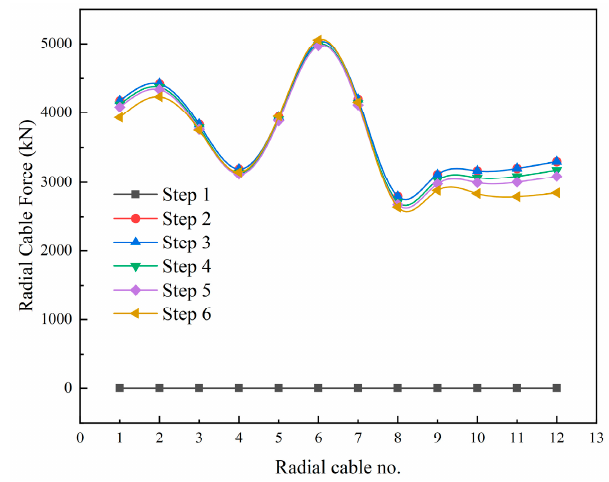
Figure 11. Radial cable force variation during the construction process. Table 5. Internal forces during the construction process. Internal Forces